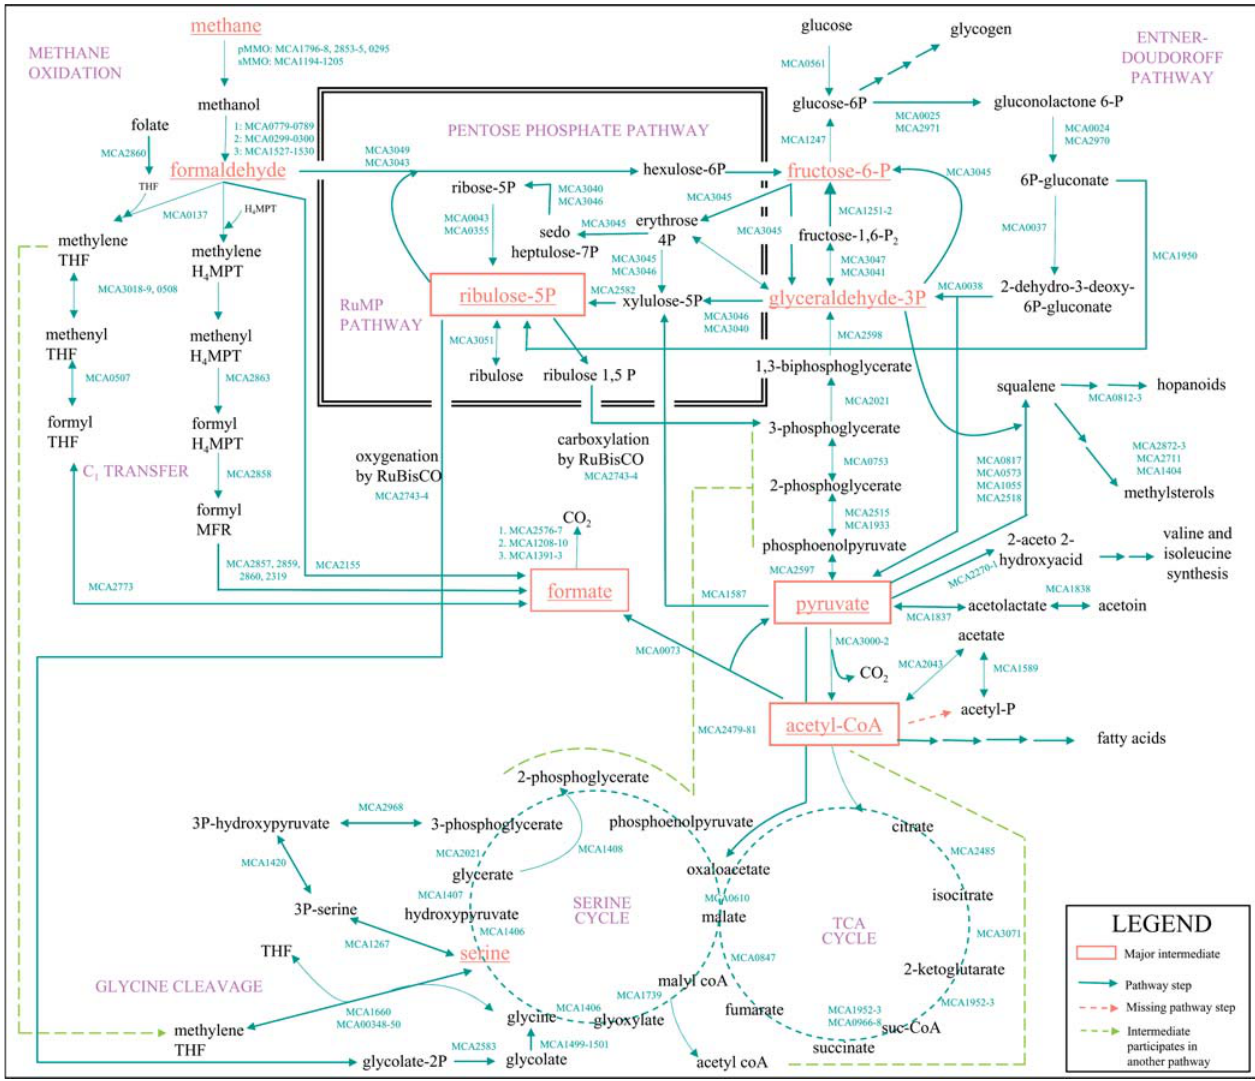
Figure 2. Predicted Central Metabolic Pathways of M. capsulatus Genomic information was used to predict the flow of carbon from methanotrophy pathways into carbon fixation pathways, and thence into glycolysis/gluconeogenesis and the TCA cycle. Locus names are indicated next to key steps. Some intermediates are omitted. DOI: